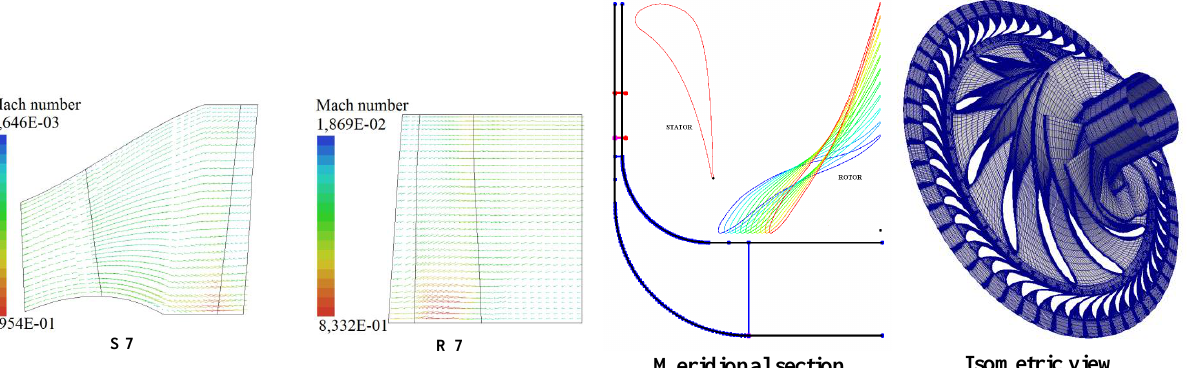
Figure 13. Velocity vectors colored by Mach number Figure 13: Velocity vectors colored by Mach number in a meridional in a meridional section at the mid blade-to-blade distance of stage 7 Figure 15: View of the flow system for radial-axial turbine – variant Figure 15. View of the flow system for radial-axial turbine – variant 1 section at the mid blade-to-blade distance of stage 7 Figure 15. View of the flow system for radial-axial turbine – variant 1